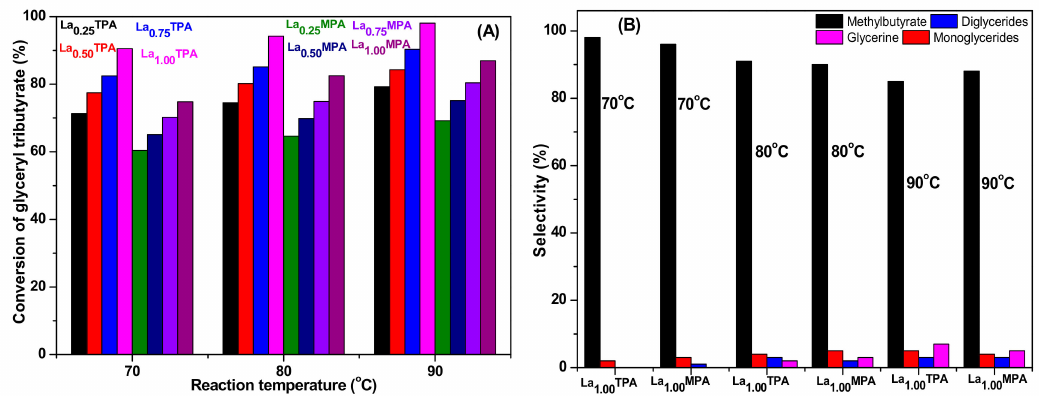
Figure 6. Influence of reaction temperature over ( A ) conversion of glyceryl tributyrate ( B ) selectivities of transesterification